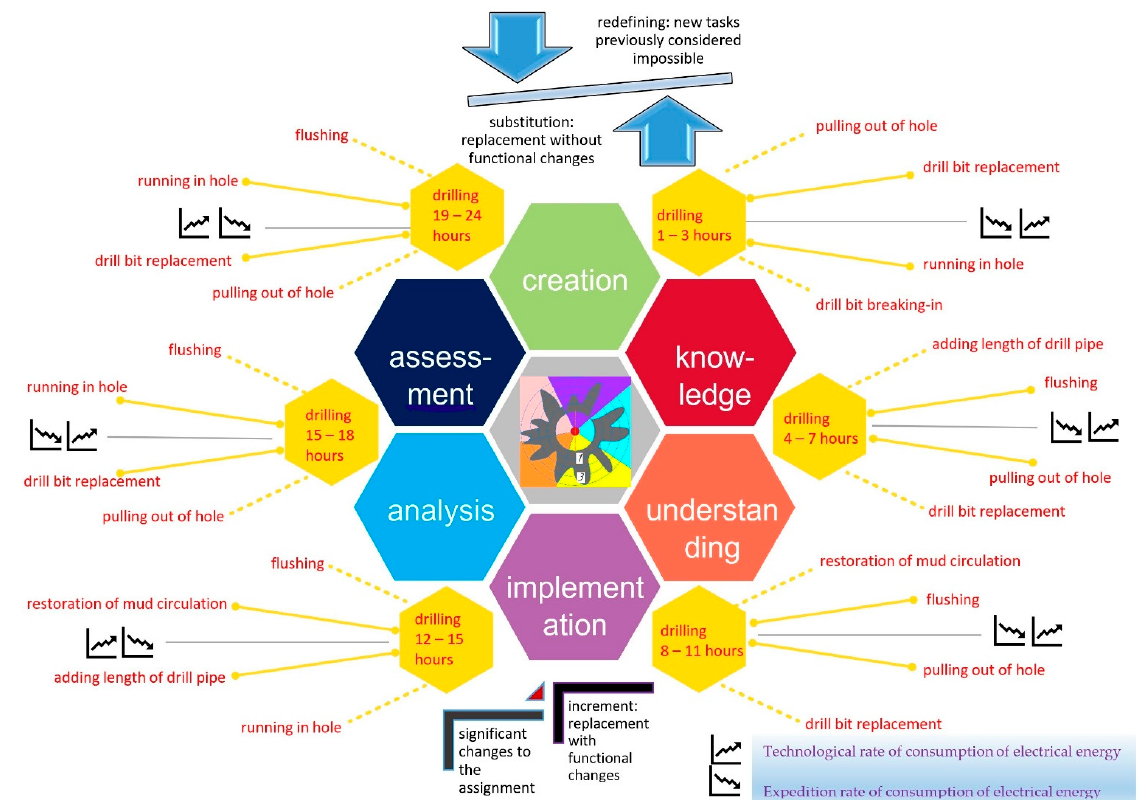
Figure 4. Indicator diagram for assessment of well performance.